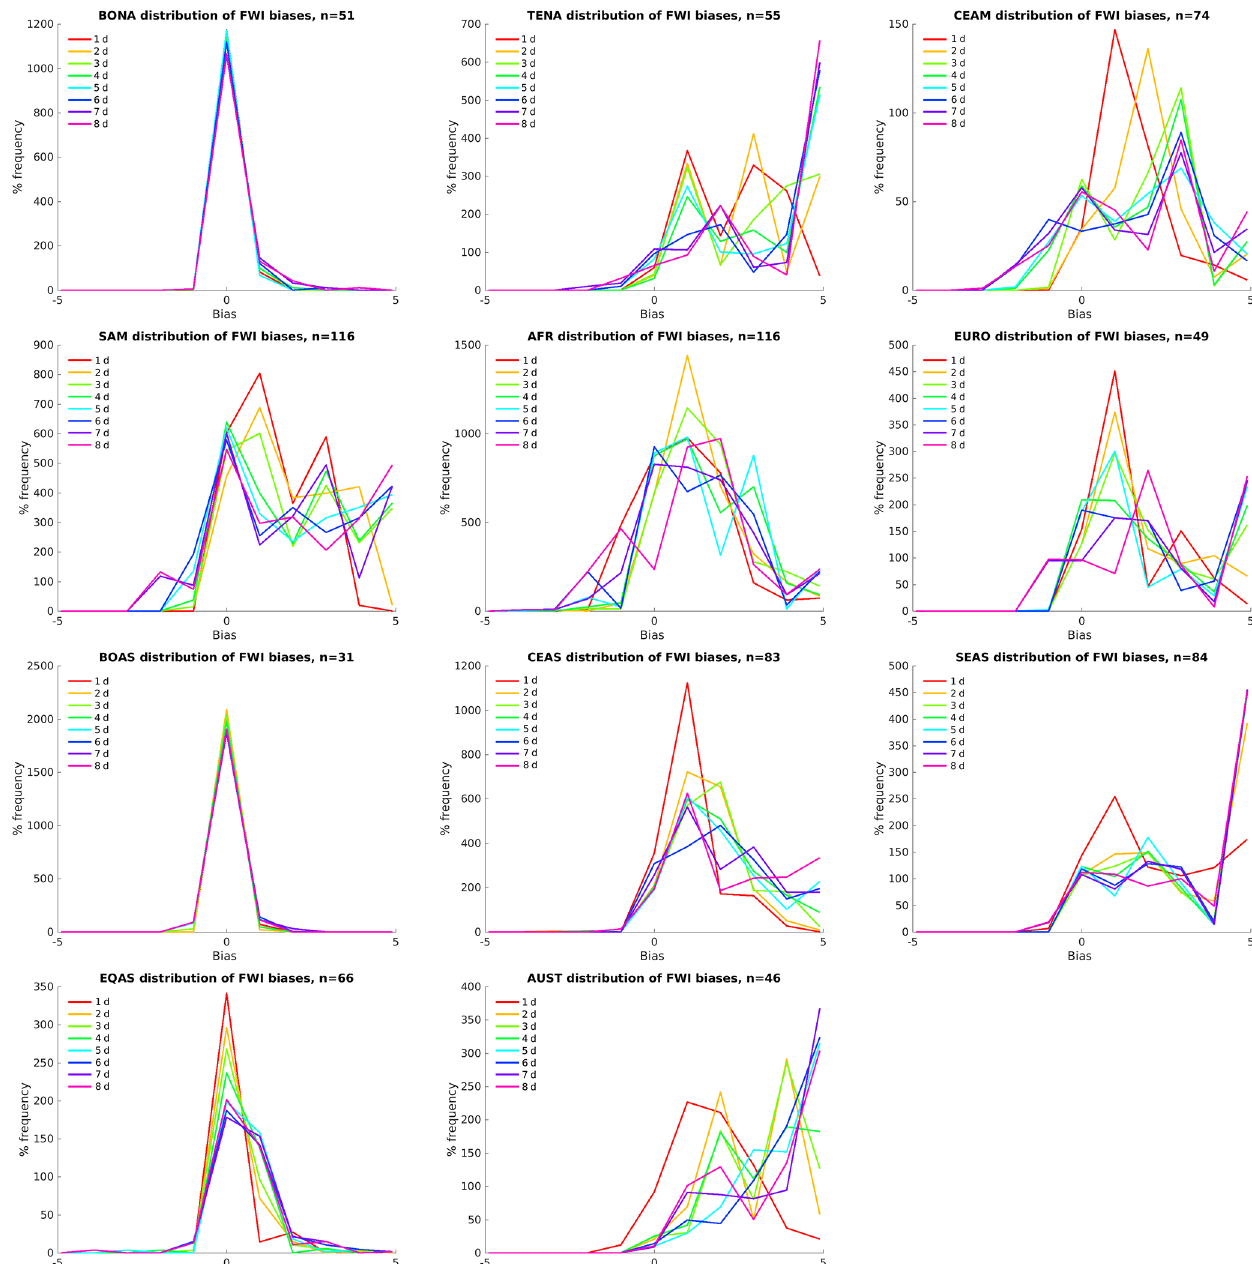
Figure 14. Same as Fig. 12 but for forecast